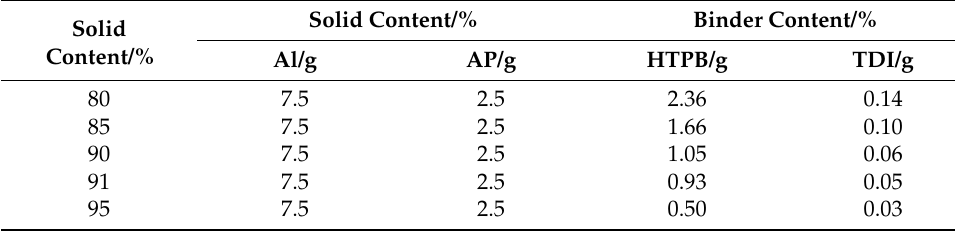
Table 1. The solid content and the specific HTPB and TDI dosage. Solid